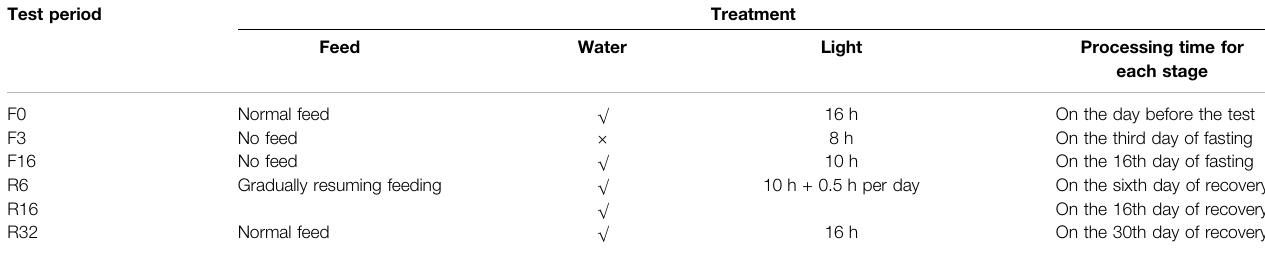
TABLE 1 | IM program induced by